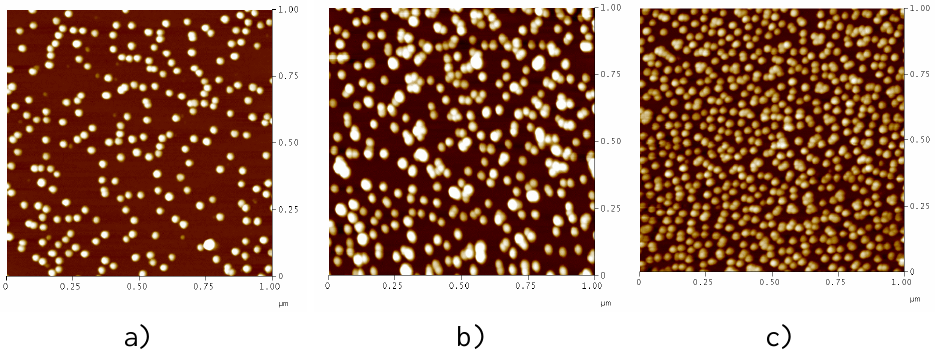
Figure 1. AFM images of 13-nm AuNPs. a) 3.5 nM, direct reduction b) 17 nM, direct reduction; c) 17 nM, centrifuging.